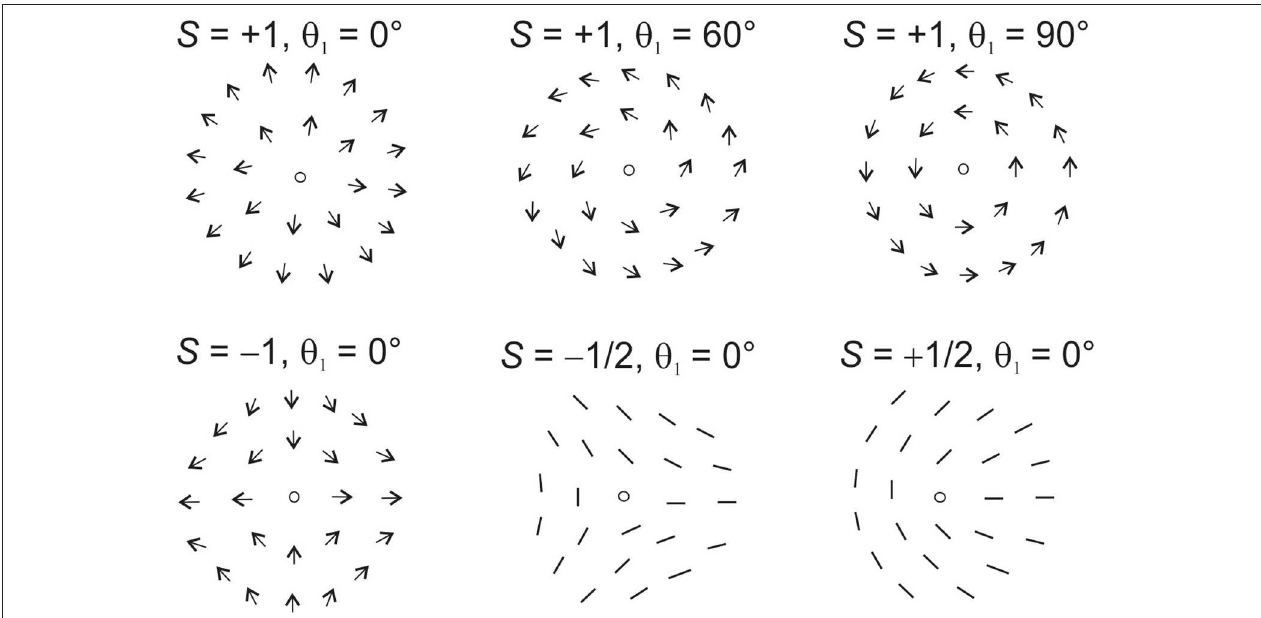
1 and 1 / 2 with different phases θ 1 . The phase of 1 defects changes their structure qualitatively (see ± ± + 1, a non-zero phase θ 1 is equivalent to a simple rotation of the defect by 6= c director field of smectic C E